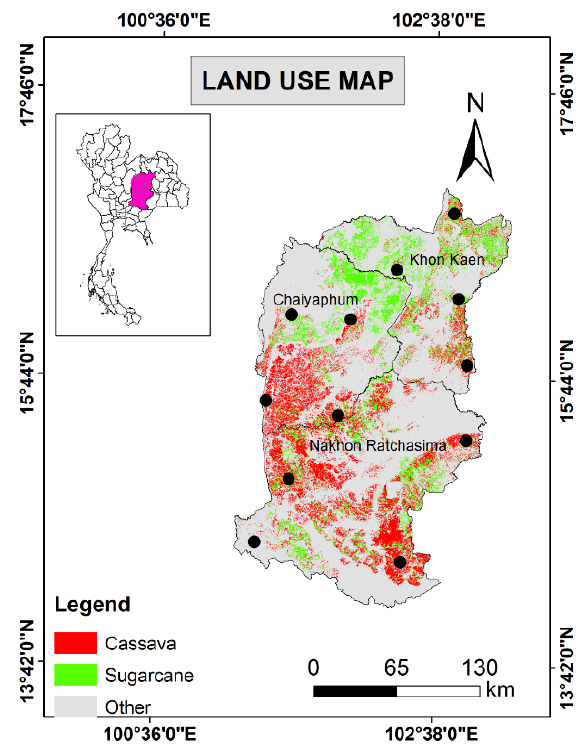
Figure 1. ArcGIS-generated land-use map of the study area for 2017 showing cassava and sugarcane fields with Thailand map (inset). fields with Thailand map